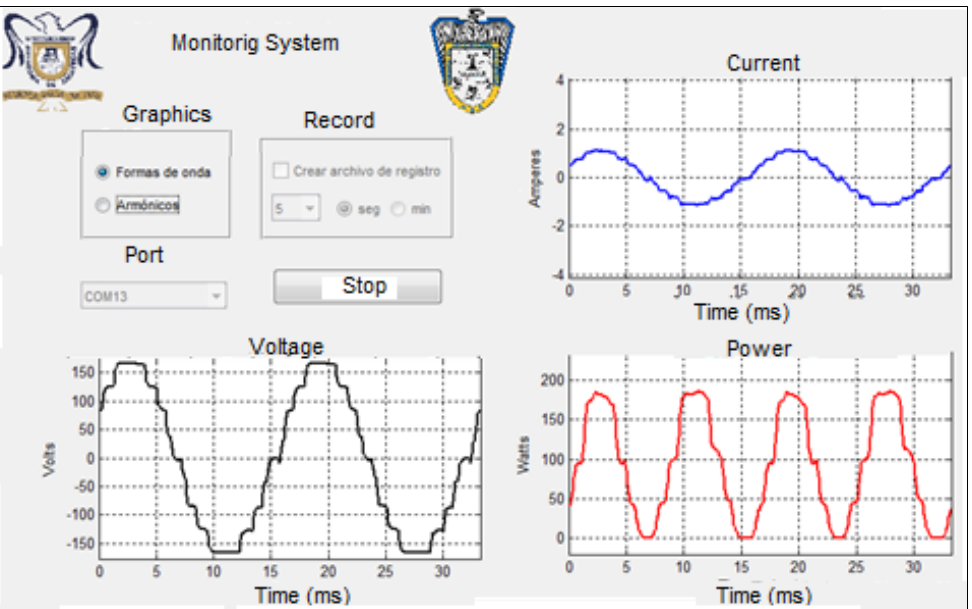
Figure 11: Waveforms obtained in the prototype with the multilevel inverter and resistive load. Source: Authors, (2021).